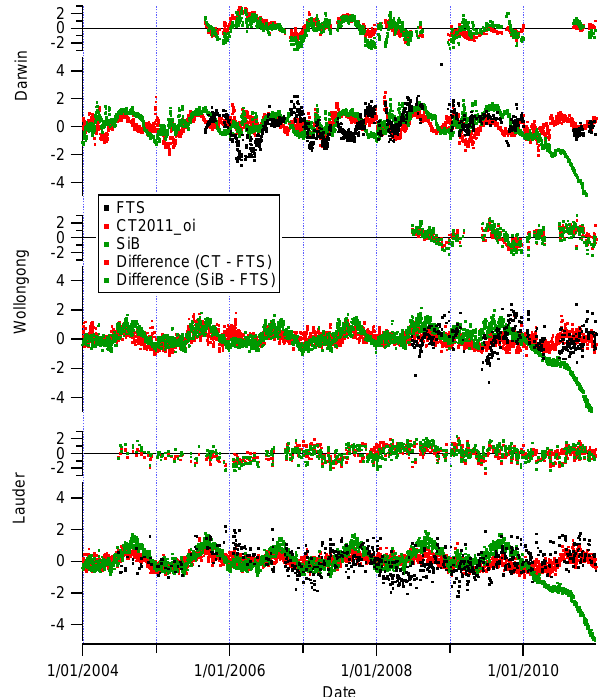
Figure 11. Linearly detrended daily average time series of TCCON (black), CT2011_oi (red) and SiB (green) at the SH TCCON sites, and the differences between the two models and the measurements (top panels).